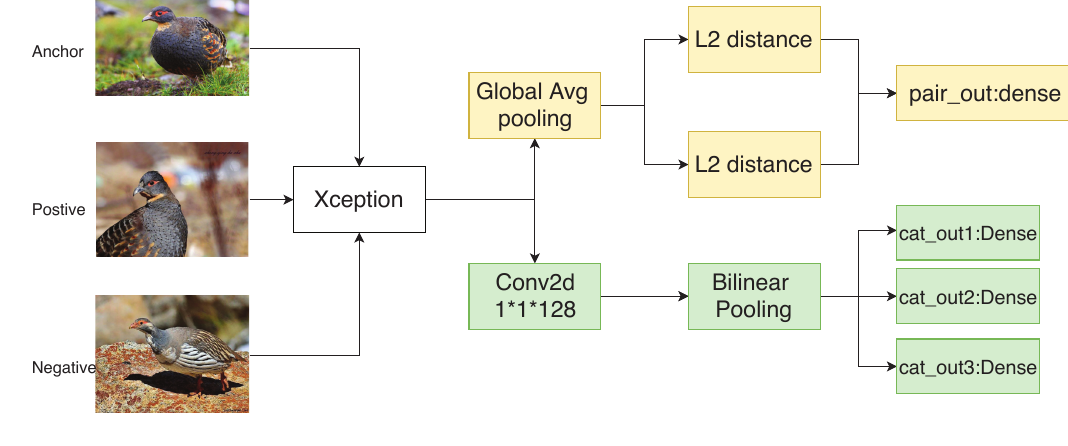
Figure 8. Architecture of our